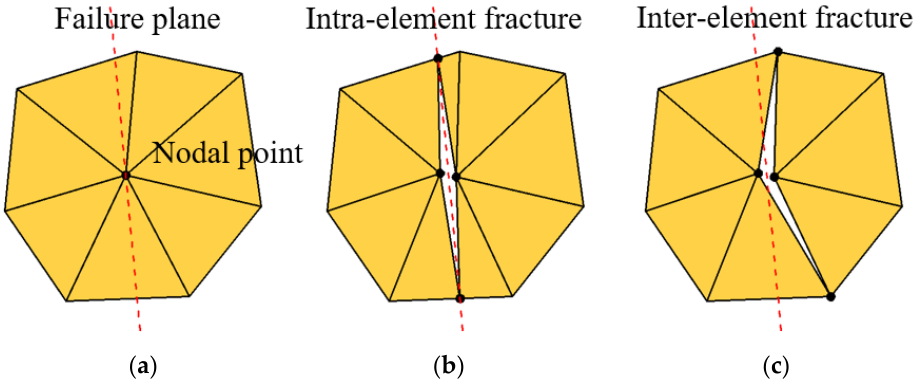
Figure 1. The crack insertion procedure: ( a ) failure plane, ( b ) intra − element fracture, ( c ) inter − element fracture.